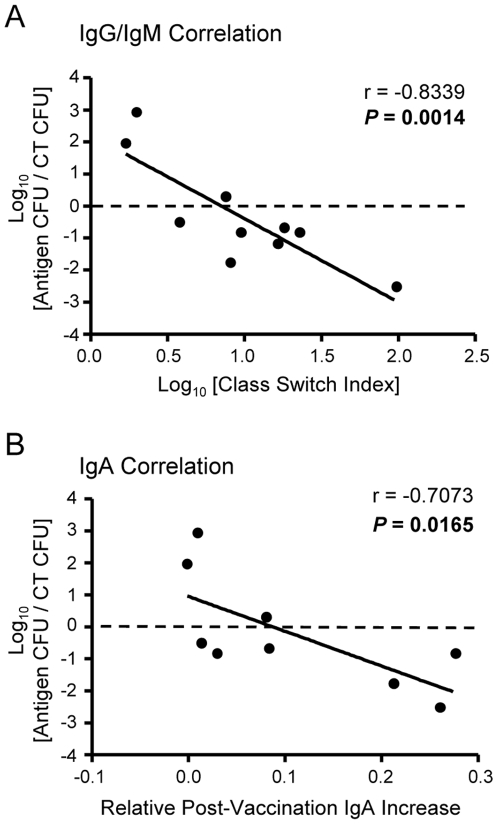
Isotype class-switching and urinary IgA correlates with vaccine-mediated protection from infection.(A) The Class Switch Index was calculated by dividing the change in serum IgG absorbance for the entire group of vaccinated mice (accounting for non-specific increases by subtracting the corresponding median change in IgG absorbance for the CT-vaccinated mouse cohort) by the same computation preformed with group median IgM absorbance values [(ΔIgGVAC−ΔIgGCT)/(ΔIgMVAC−ΔIgMCT)]. The Class Switch Index was then plotted against the normalized bladder CFU (group median CFUVAC/group median CFUCT) for each vaccination experiment. Thus, each individual point reflects the collective data from an experiment involving 10 vaccinated and 10 CT mice (n = 203). Lower normalized CFU values indicate enhanced bacterial clearance after challenge, where higher class switch indices represent superior B cell activation by comparing the increase in IgG compared to the increase in IgM. (B) Normalized bladder CFU values from each vaccination experiment are plotted against the median change in absorbance of antigen-specfic IgA detected in the urine (ΔIgAVAC). Pearson correlation coefficient (r) and P values are shown.